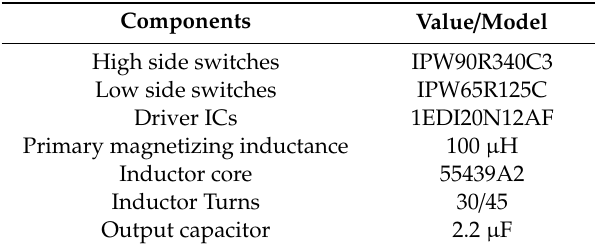
Table 9. Main components of the prototype of the proposed SSBBI.